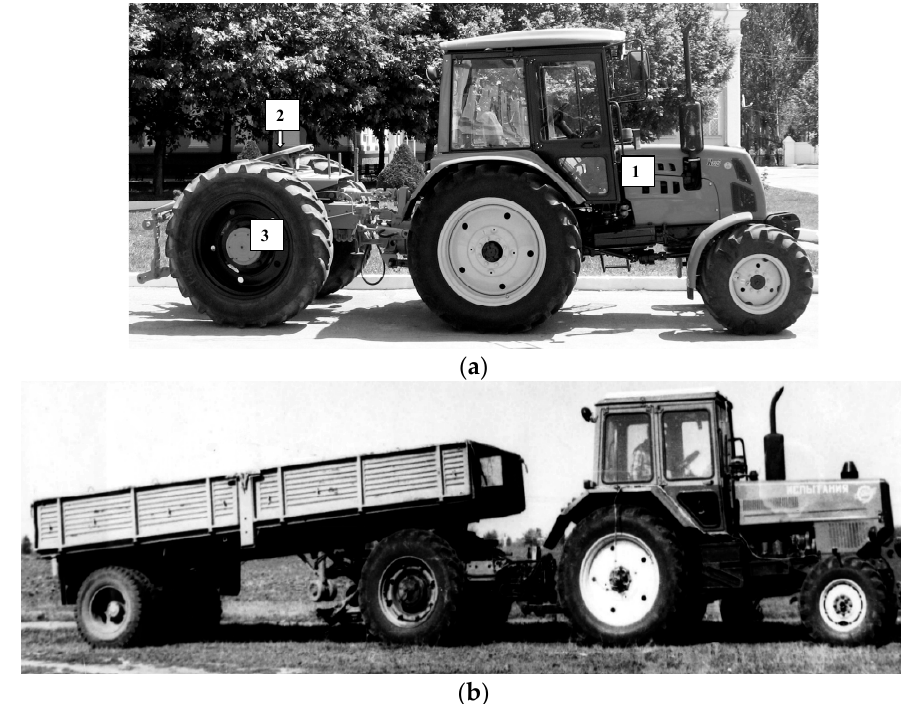
Figure 1. Modular draft device: ( a ) general view of MDD with fifth-wheel coupling, ( b ) unit in operation: (1) power module (PM); (2) saddle semitrailer device; (3) technological module